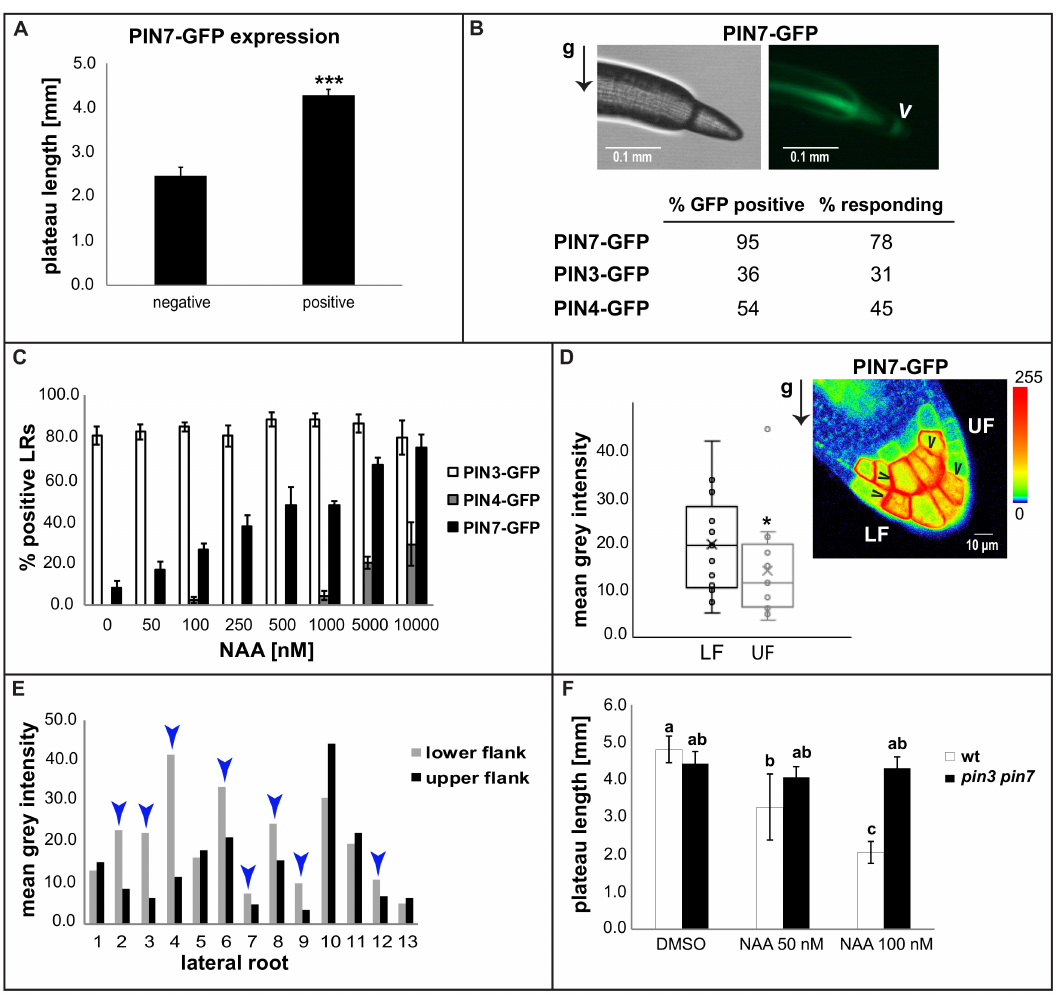
Figure 4. PIN7 has a preferential role in plateau phase termination. ( A ) Examination of higher order LRs (6–8 DAG) revealed a positive correlation between the likelihood of PIN7 expression and the length of the plateau phase. A representative experiment is shown ( n ≥ 60 LRs; n ≥ 30 seedlings per experiment). *** p < 0.001 (Student’s t -test). ( B ) Compared with PIN3 and PIN4, PIN7 was more frequently detected (95%) in advanced stage III LRs (>4 mm). In 78% of tracked cases, the expression of PIN7-GFP at that developmental point correlated with the subsequent graviresponse (within 12 h), leading to exit from the plateau. An arrowhead indicates pPIN7-GFP expression at the root tip. An arrow denotes the gravity (g) vector. ( C ) 4-DAG seedlings of pPIN3::PIN3-GFP, pPIN4::PIN4-GFP and pPIN7::PIN7-GFP reporter lines were treated for three days with the indicated concentrations of NAA and the presence of a detectable signal of the corresponding PIN in the tip of stage I and II LRs was examined. An average of three experiments is shown ( n ≥ 30 LRs per experiment). ( D , E ) The expression of PIN7-GFP in columella cells of the root tip exhibits polarization in a high percentage of late stage III LRs. Polarization was assessed by measurement of PIN7-GFP fluorescence intensity at lateral plasma membrane domains of the outermost columella cells at the lower flanks (LF) compared with those at the upper flanks (UF). Arrowheads indicate asymmetric PIN7-GFP distribution. A semiquantitative color-coded heat-map of the PIN7-GFP signal is provided ( D ). Results from a representative experiment are presented ( n > 10 LRs, n > 7 seedlings per experiment) in ( D , E ). ( E ) displays the values of the individual LRs. The blue arrowheads in ( E ) indicate cases of polarization towards the gravity vector (LF > UF). One asterisk in D denotes p < 0.05 (Student’s t -test). ( F ) pin3 pin7 mutants show resistance to the reduction of the plateau length caused by NAA treatments on the wild types (4-DAG seedlings). A representative experiment is shown ( n > 30 LRs per experiment). Error bars represent SEM. Statistical significance was evaluated by two-way ANOVA followed by Tukey’s multiple comparison test. Distinct letters (a, b, c) indicate statistically significant differences ( p < 0.05).